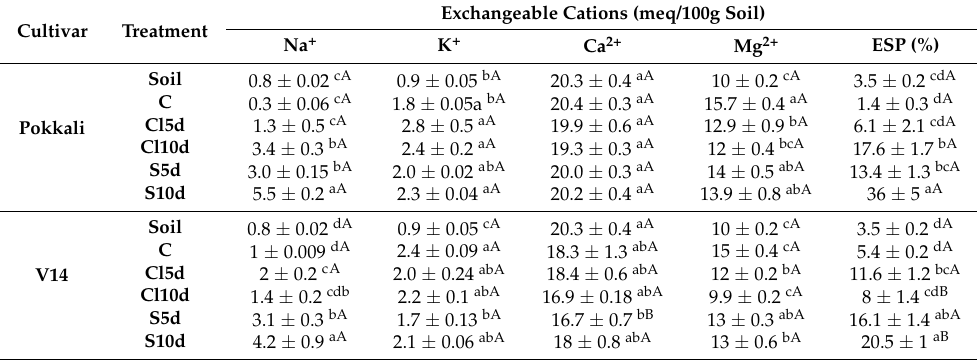
Table 2. Exchangeable cations content and exchangeable sodium percentage (ESP) of uncultivated and unsalted soil (Soil), unsalted soil cultivated with control plants (C) and cultivated soil salinized by 5 dS.m − 1 (5d) or 10 dS.m − 1 (10d) of NaCl (Cl) or Na 2 SO 4 (S). Plants belong to two distinct cultivars (Pokkali: salt-resistant and V14: salt-sensitive). Parameters were recorded after plant harvest. Exchangeable Cations (meq/100g Soil) Cultivar Treatment